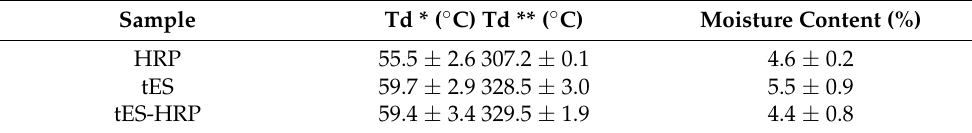
Figure 3. Nanoencapsulation of HRP. Size-exclusion chromatogram of free HRP ( a ), tES ( b ), and tES-HRP ( c ), at pH 8.0. Each fraction was analyzed for HRP activity and the data overlaid on the respective chromatogram (Note: Fractions of the tES-HRP peak (rectangle box) were pooled and concentrated for various experiments). Hydrodynamic diameter measurements of free HRP ( d ), tES ( e ), and tES-HRP ( f ) from DLS experiments. ( g ) SDS-PAGE analysis of nanoencapsulation. Lane 1 (M-protein marker), Lane 2 (tES) showing single band corresponding to ~20 kDa of subunit, Lane 3 (HRP) showing a single band of ~44 kDa, and Lane 4 (tES-HRP) showing two bands corresponding to subunit (~20 kDa) and HRP (~44 kDa). The quantification analysis of lane 4 through densitometry exhibited a 12-time higher intensity for tES (band intensity of 4.28 × 10 8 ) compared to HRP (band intensity of 3.55 × 10 7 ). ( h ) Thermogravimetric analysis (TGA) of the lyophilized proteins to determine the residual moisture content. The TGA curves of HRP, tES, and tES-HRP are shown. Table 1. Decomposition temperatures (Td) and moisture content (%) of freeze-dried